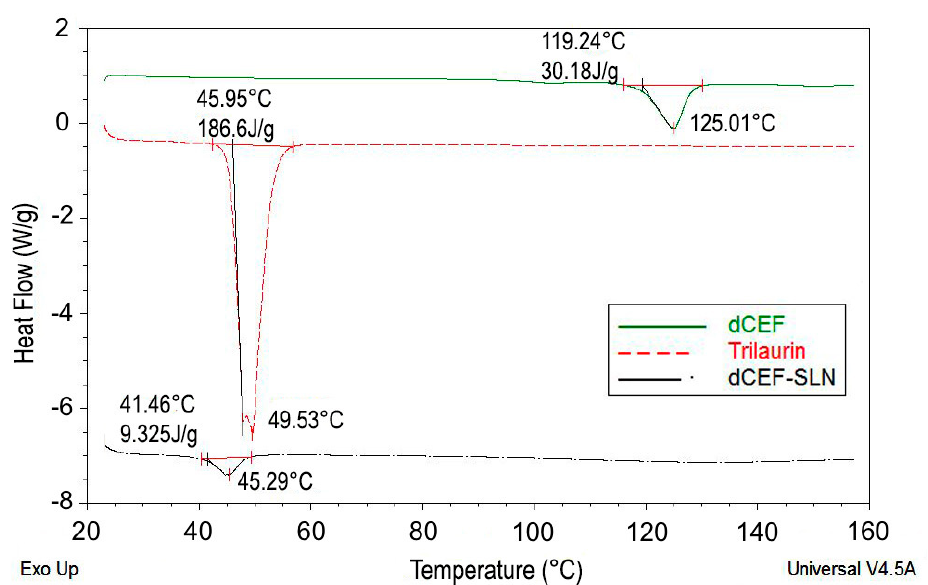
Figure 5. DSC thermograms of raw dCEF (upper solid curve), raw trilaurin (intermediate dotted curve) and dCEF-SLN (lower dash-dotted curve).